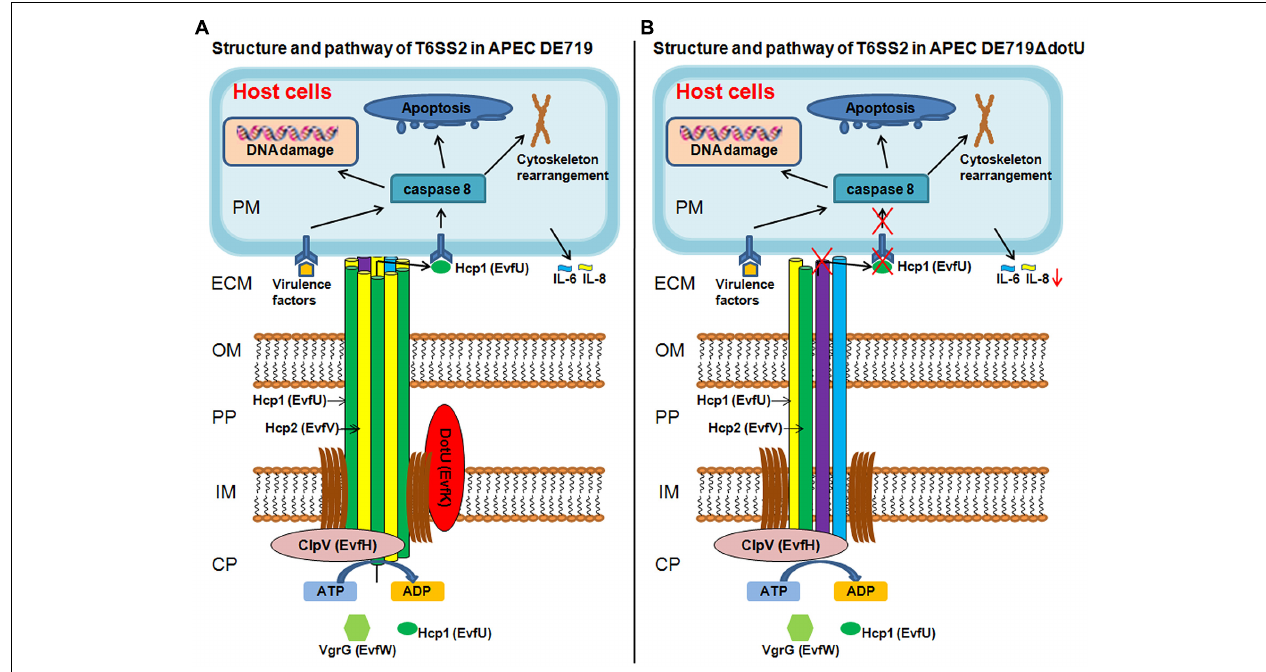
FIGURE 9 | Schematic T6SS2 structure and pathway in APEC dotU mutant. (A) T6SS2 structure and pathway in APEC strains. The channel through the bacterial periplasm is Hcp1, Hcp2, and other proteins that transport effector protein Hcp1 to the ECM. Hcp1 could be recognized by a specific receptor of host cells, leading to cytoskeleton rearrangement, apoptosis, and cytokine release. As the core component, DotU stabilizes the secretion machinery. (B) Deletion